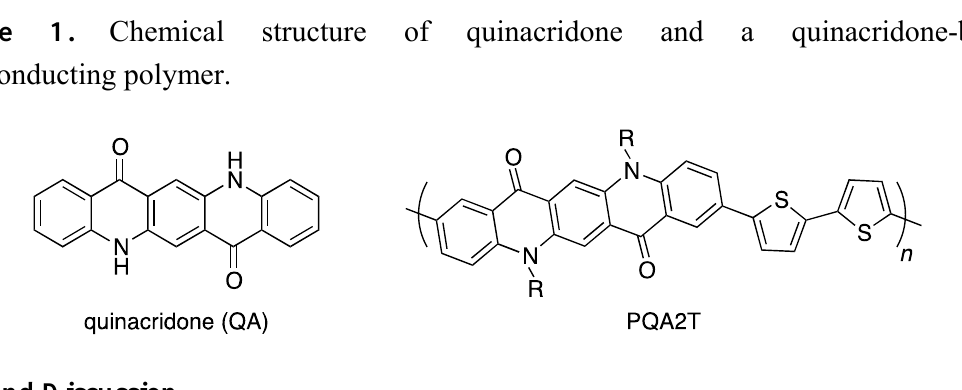
Figure 1. Chemical structure of quinacridone and a quinacridone-based semiconducting